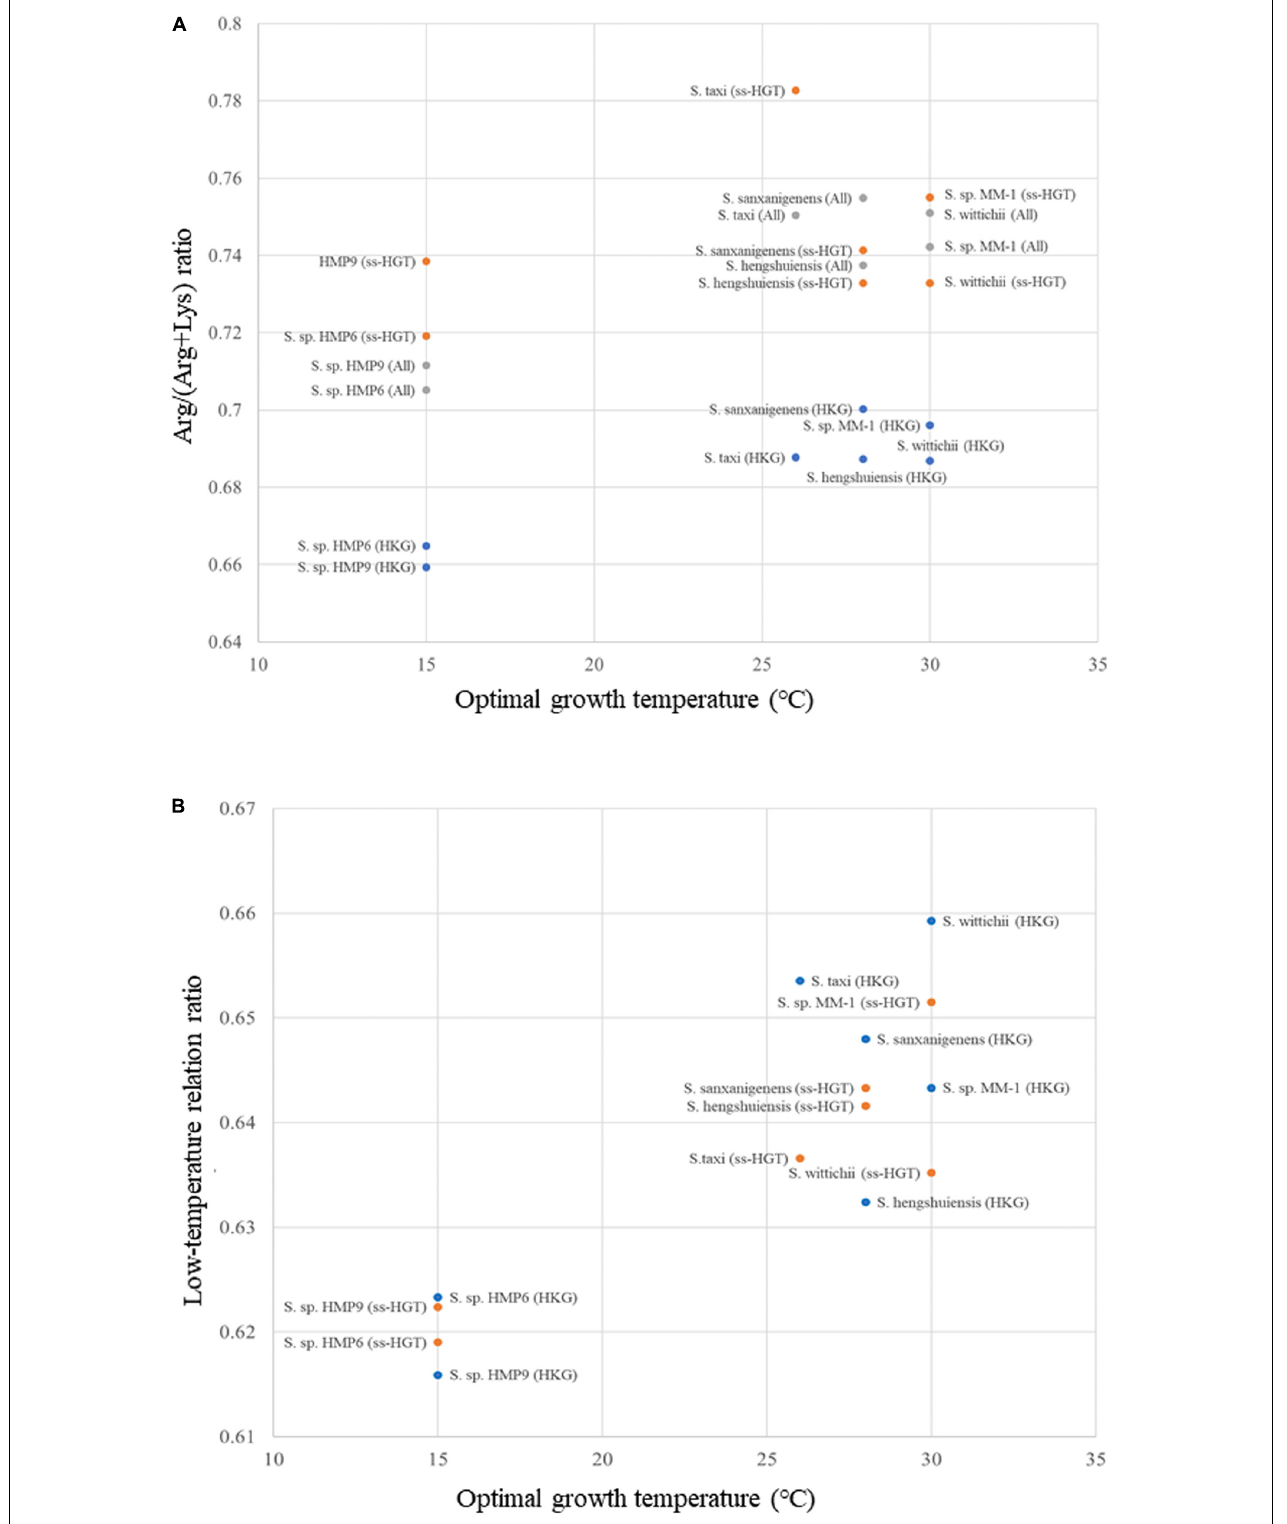
FIGURE 10 | Scatter plot of amino acid ratio versus optimal growth temperature of Sphingomonas strains. (A) Arg/(Arg + Lys) ratio. Blue: housekeeping genes (HKG); orange: strain-specific HGT candidates (ss-HGT); gray: all genes (All). (B) Low-temperature relation ratio. Blue: housekeeping genes (HKG); orange: strain-specific HGT